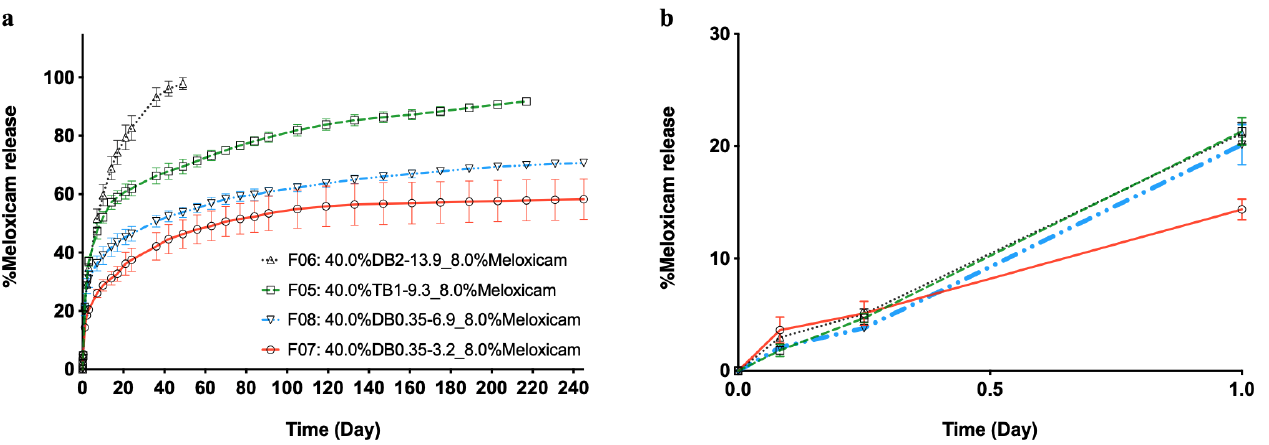
Figure 4. Meloxicam release from (m)PEG–PTMC suspension formulations with different triblock and diblock copolymers ( a ) and the zoomed released over first 24 h ( b ).